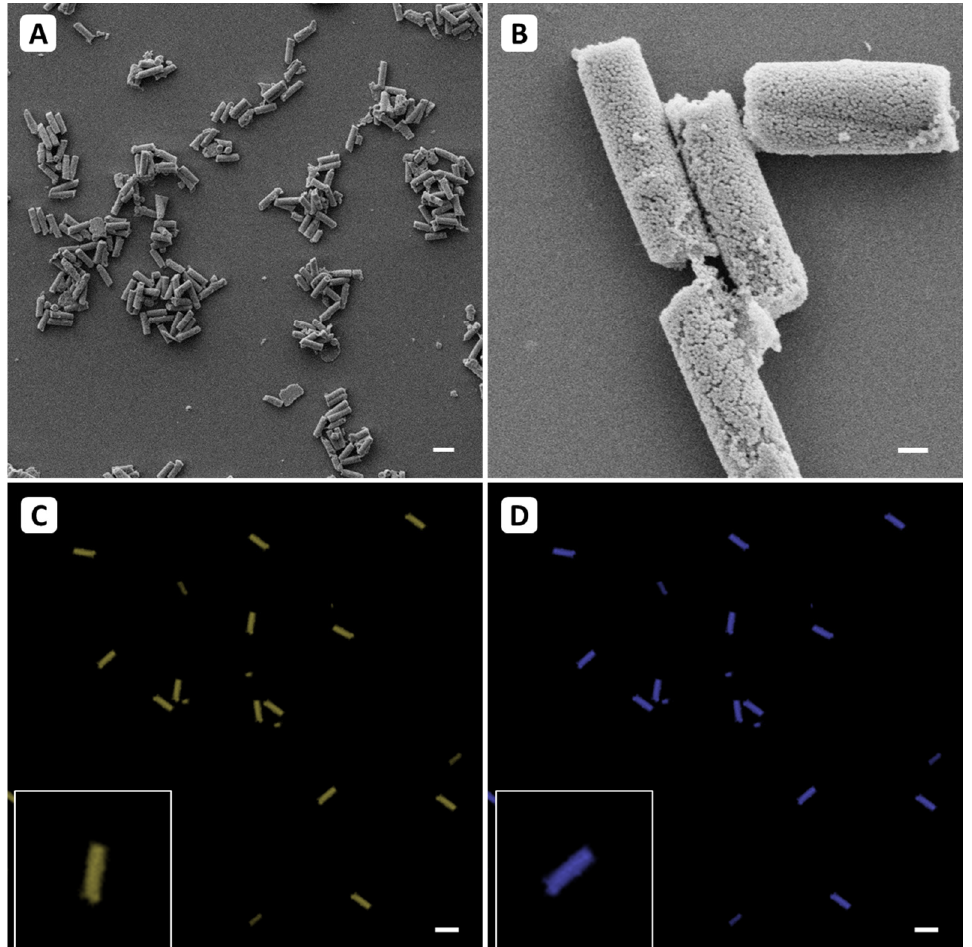
Figure 2. The curcumin and siRNA loaded formulation under the SEM ( A , B ) and CLSM ( C , D ). ( A ) The SEM image shows that neither the stability nor the morphology of the microrods are affected by drug loading. ( B ) Here, the nanostructure as well as the cylindrical shape is visible. ( C ) Visualization of curcumin fluorescence of λ em = 542 nm was realized after excitation at λ ex = 440 nm. Here, the homogeneous loading of the mSNPs can be seen. ( D ) To visualize the double-stranded siRNA used for CLSM measurement, the formulation was treated with ethidium bromide to generate intercalation, which allowed the detection of a signal at λ ex = 526 nm, λ em = 605 nm. The fluorescence is also homogeneously distributed over the whole microparticle surface, as shown in the magnified inset of ( C , D ), indicating a homogeneous loading along the particle. Representative sections were used for all images. Scale represents 10 µm for ( A , C , D ) and 1 µm for ( B ).